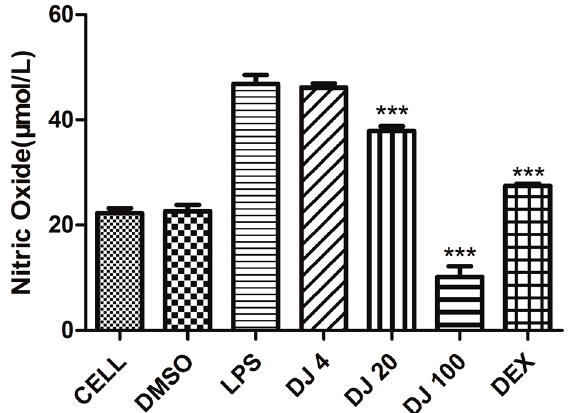
Figure 1. NO inhibitory effects of W. glabra essential oil on lipopolysaccharide (LPS)-activated RAW 264.7 cells. CELL: blank control; DMSO: blank control with DMSO; LPS: LPS control; DJ4, DJ20 and DJ100: